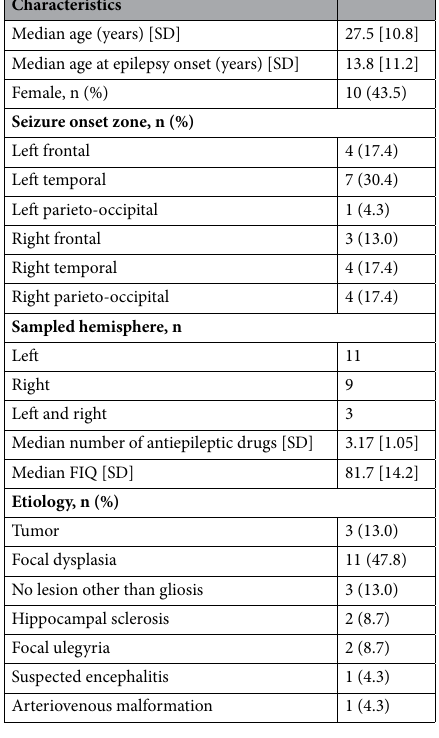
Table 1. Patient profiles. SD standard deviation, FIQ full-scale intelligence